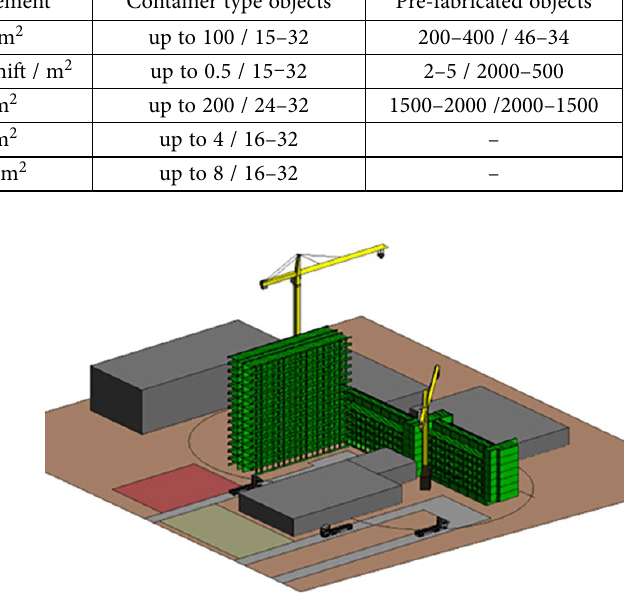
Figure 14. A real example of the use of the algorithm: selecting the locations for the temporary objects